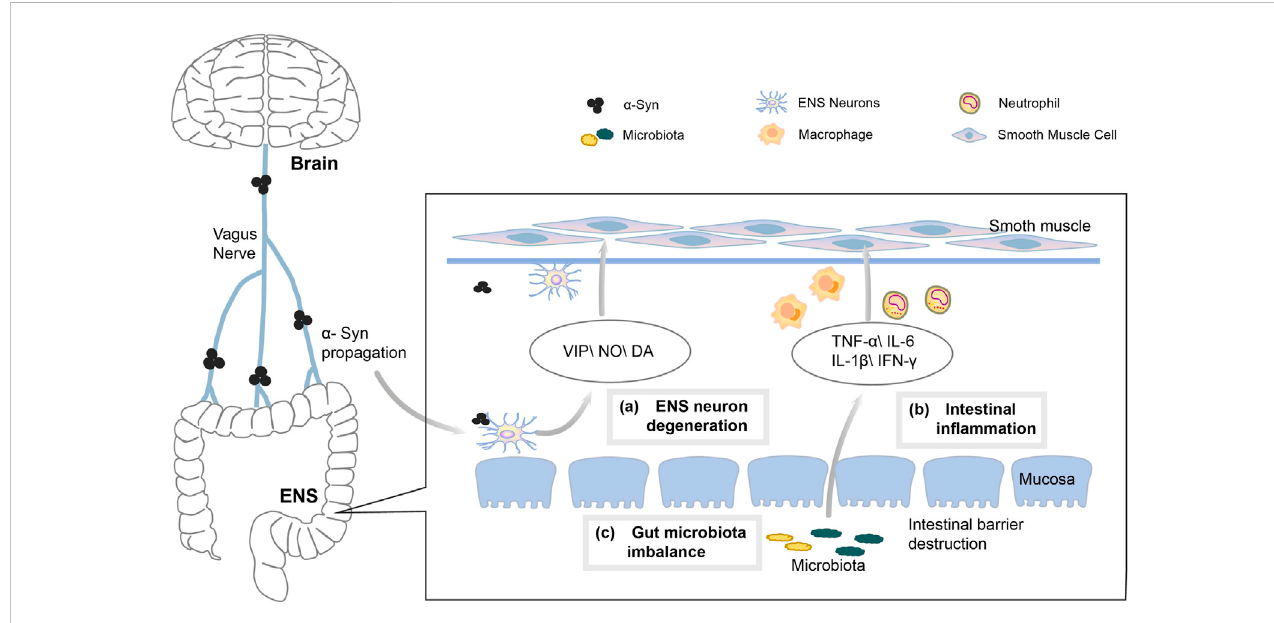
FIGURE 10 Mechanism of PD causing